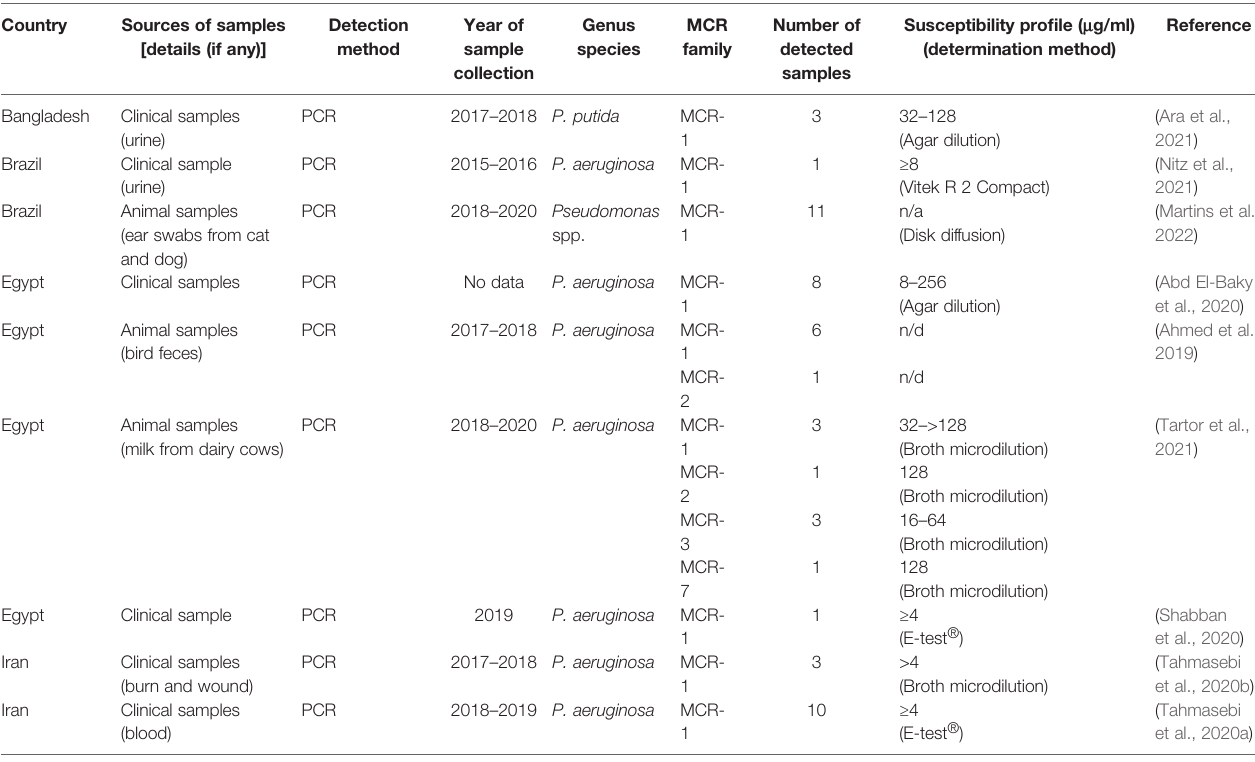
TABLE 2 | Summary of the mcr gene identi fi ed in Pseudomonas spp., specimen description, MCR family, and susceptibility pro fi le.